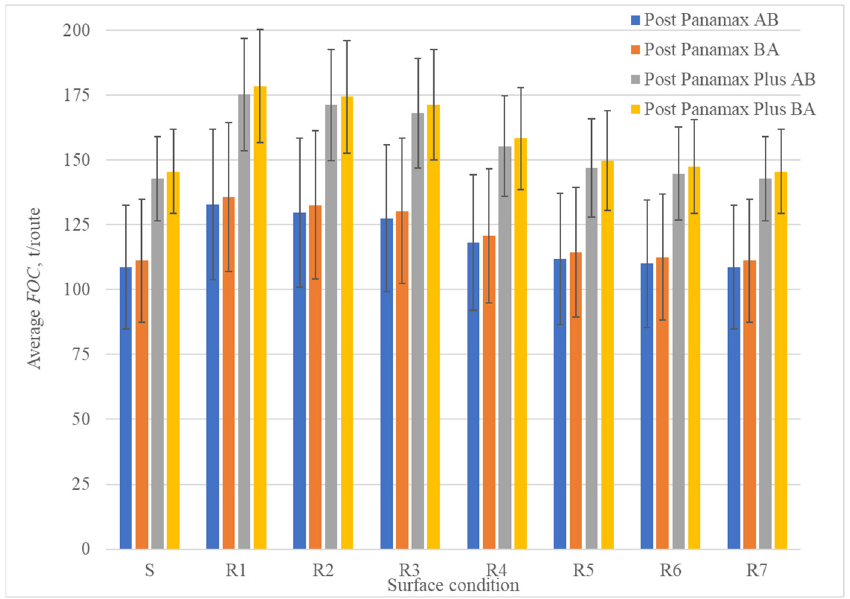
Figure 4. The obtained average FOC per route